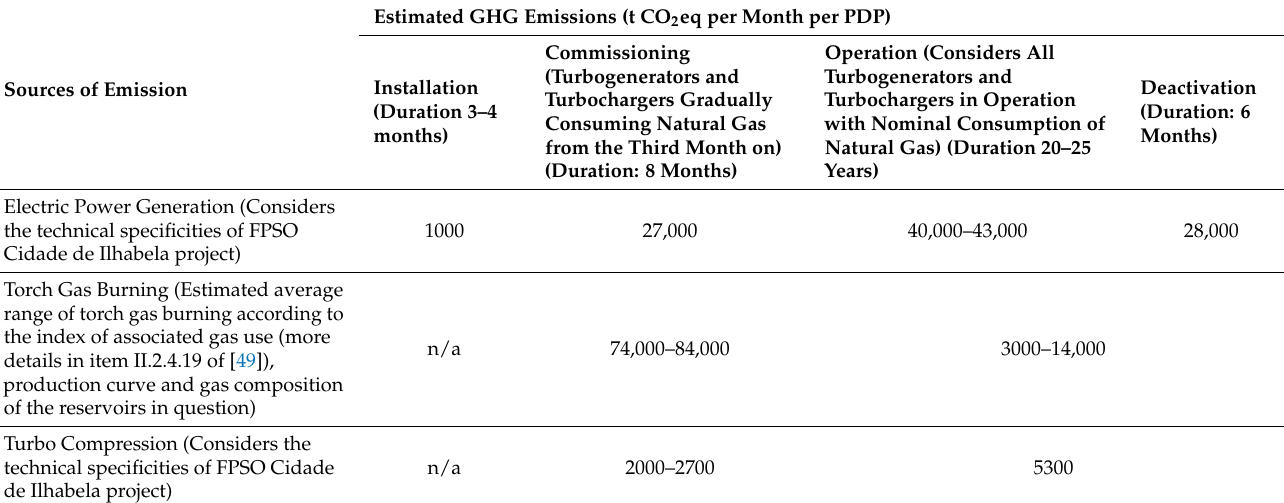
Table 5. Average estimated greenhouse gas emissions by Production Development Project (PDP) activities in the Stage 2 project (Table